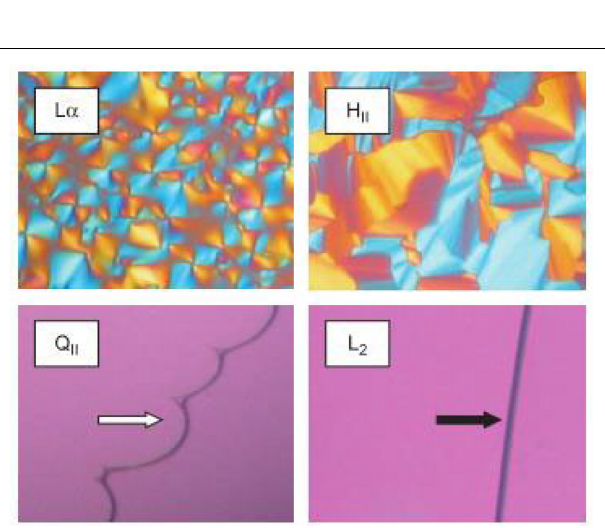
FIGURE 3 | Schematic diagram of the in vitro digestion pH-stat apparatus. Digestion of lipids from the formulation generates fatty acids resulting in a drop in pH. This is compensated by automated addition of NaOH to maintain a fixed pH value, enabling the tracking of digestion kinetics on the computer.